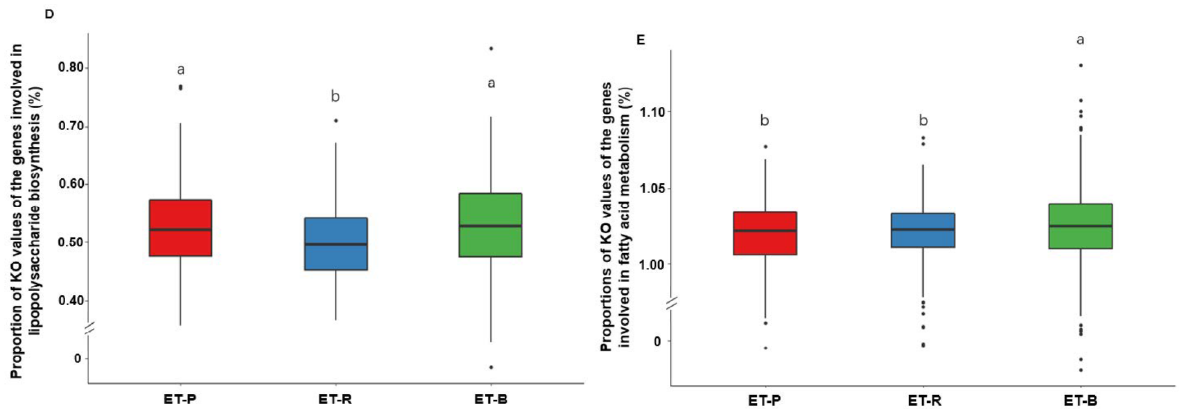
Figure 6. Heatmaps of abundant genes involved in metabolic functions determined by ( A ) PICRUSt2 and ( B – E ) the relative abundance of the genes related to significant metabolic functions in three enterotypes. ( A ) The association of the genes related to different functions in three enterotypes. ( B ) Propionate metabolism in three enterotypes. ( C ) Starch and sucrose metabolism in three enterotypes. ( D ) Lipopolysaccharide biosynthesis in three enterotypes. ( E ) Fatty acid metabolism in three enterotypes. LDH, L-lactate dehydrogenase; Figure 1. phosphate adenylyltransferase; GLGX, glycogen debranching enzyme; IMA, oligo-1,6-glucosidase; INV, beta-fructofuranosidase; SCRA, sucrose phosphoenolpyruvate-dependent sucrose phosphotransferase system permease component; LPXB, lipid-A-disaccharide synthase; LPXK, tetraacyldisaccharide 4′-kinase; KDSB, 3-deoxy-mannooctulosonate cytidylyltransferase; KDSA, 2-dehydro-3-deoxyphosphooctonate aldolase; LPXL, Kdo2-lipid IVA lauroyltransferase/acyltransferase; KDTA, 3-deoxy-D-manno-octulosonic-acid transferase; LPXC, UDP-3-O-(3-hydroxymyristoyl) N-acetylglucosamine deacetylase; FABI, enoyl-[acyl-carrier protein] reductase I; FABD, [acyl-carrier- protein] S-malonyltransferase; ACSL, long-chain acyl-CoA synthetase; FABF, 3-oxoacyl-[acyl-carrier-protein] synthase II; FABB, 3-oxoacyl-[acyl-carrier-protein] synthase I; LPXC-FABZ_2, UDP-3-O-[3-hydroxymyristoyl] N-acetylglucosamine deacetylase/3-hydroxyacyl-[acyl-carrier-protein] dehydratase; FABG, 3-oxoacyl-[acyl-carrier protein] reductase. KO, KEGG Orthologues. Different alphabets (a,b,c) represented significant differences among the different bacteria in the family level by Tukey’s test at p < 0.05. ET-P, Prevotellaceae ; ET-R, Ruminococcaceae ; ET-B, Bacteroidaceae